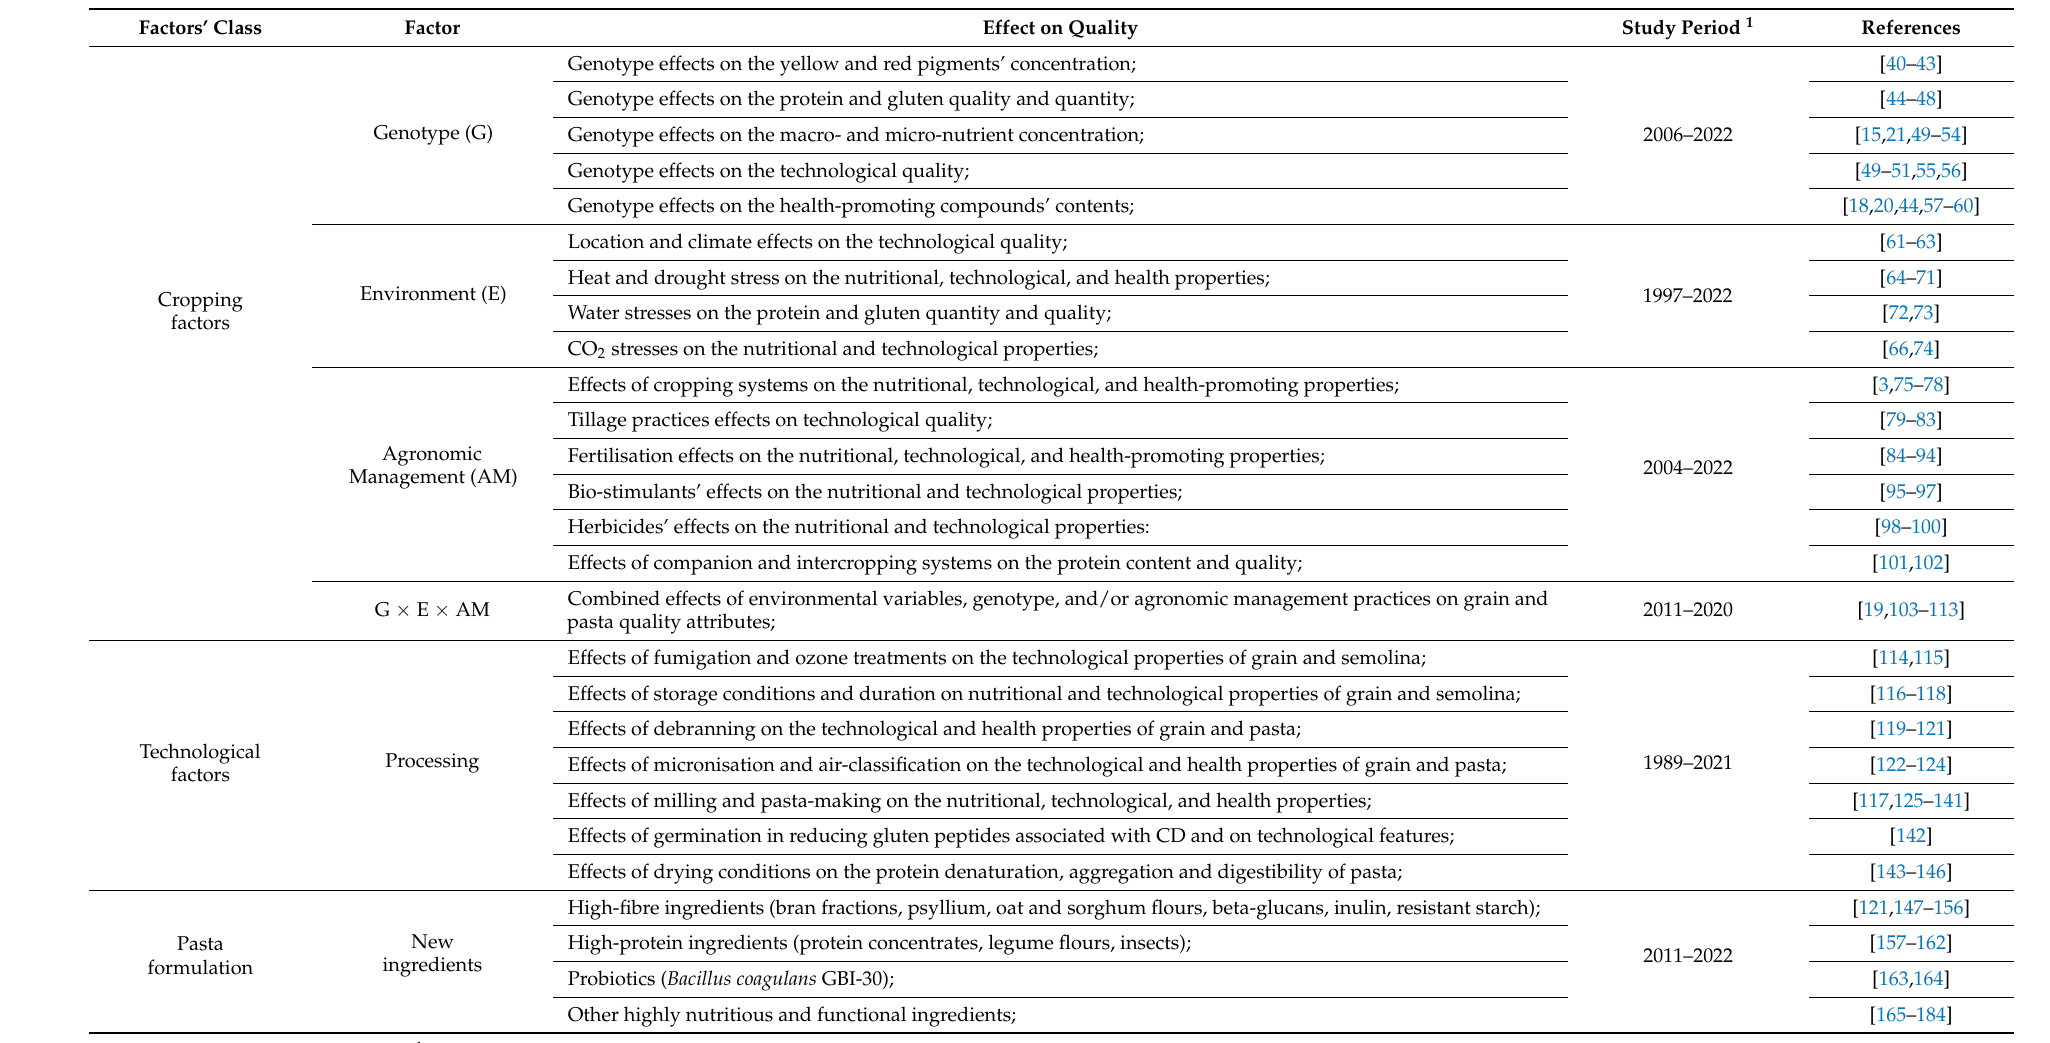
Table 1. Classification of the reviewed studies according to the type of variable